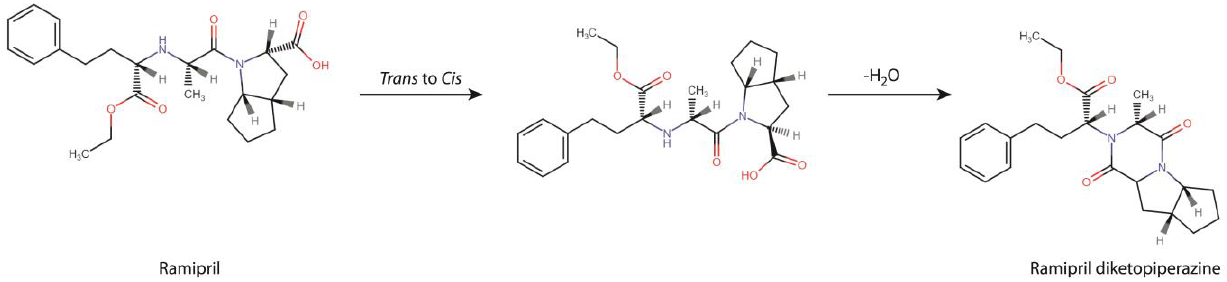
Figure 5. RAM degradation pathway under dry air conditions.